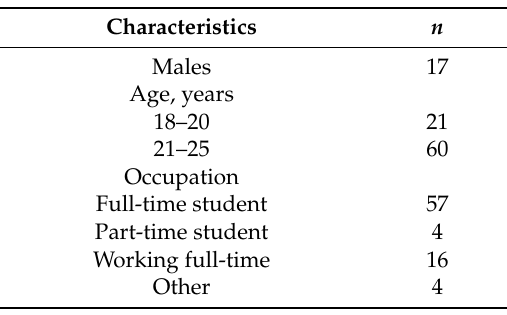
Table 1. Survey participant characteristics ( n = 81).